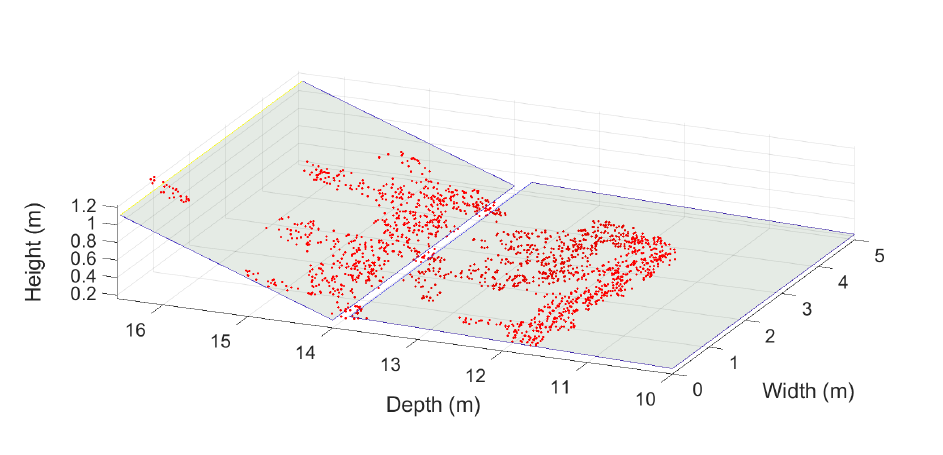
Figure 27. Ground 3D fire points and propagation